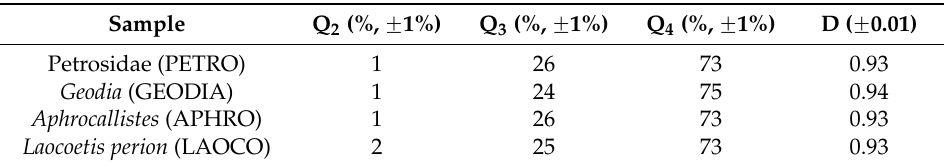
Table 2. Relative contribution of Q 2 , Q 3 and Q 4 species to the 29 Si solid state nuclear magnetic resonance (NMR) spectra of the four samples as obtained from